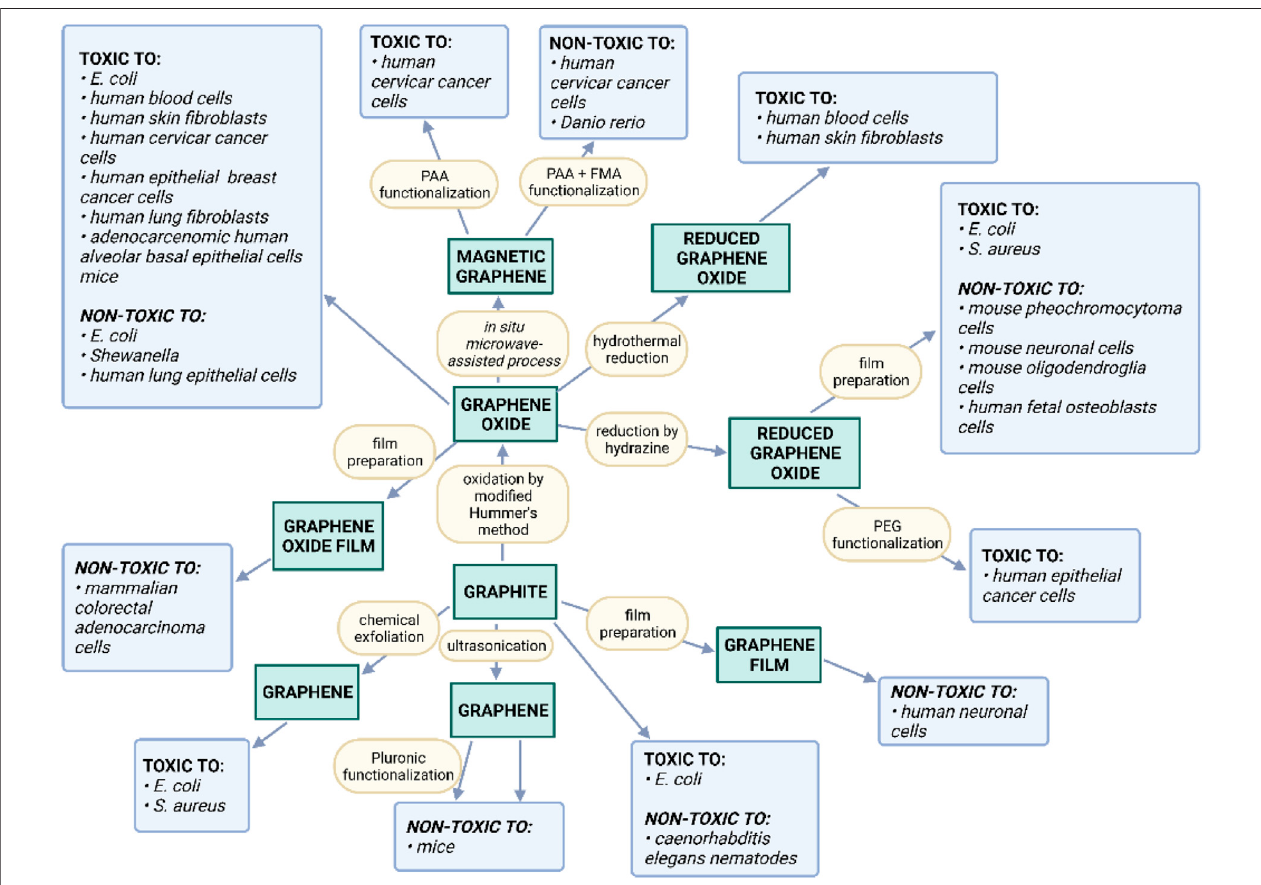
FIGURE 4 | Summary of the observed toxic effects of GFMs in terms of their production methods and the impact of possible functionalization (Reproduced with permission from (Jastrze ˛ bska et al., 2012)).